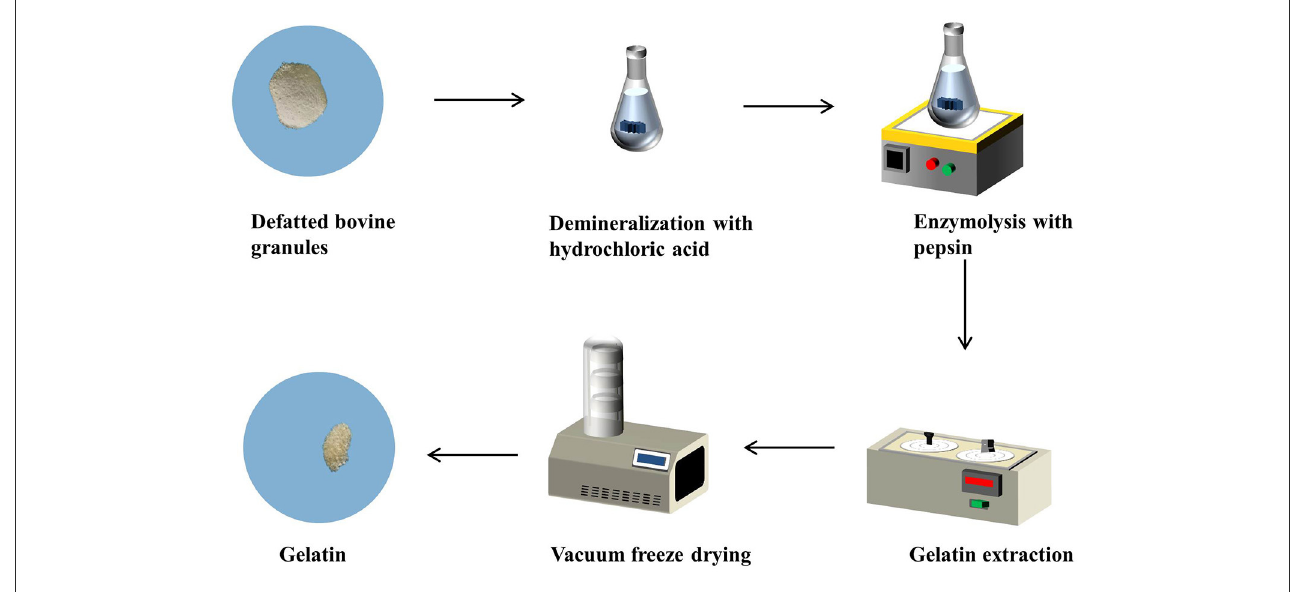
FIGURE1 A flowsheet of gelatin extraction by the enzymatic method.